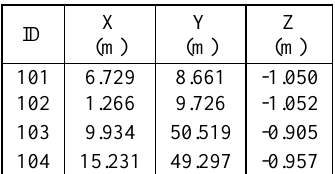
Table 5. Target coordinates in a local reference